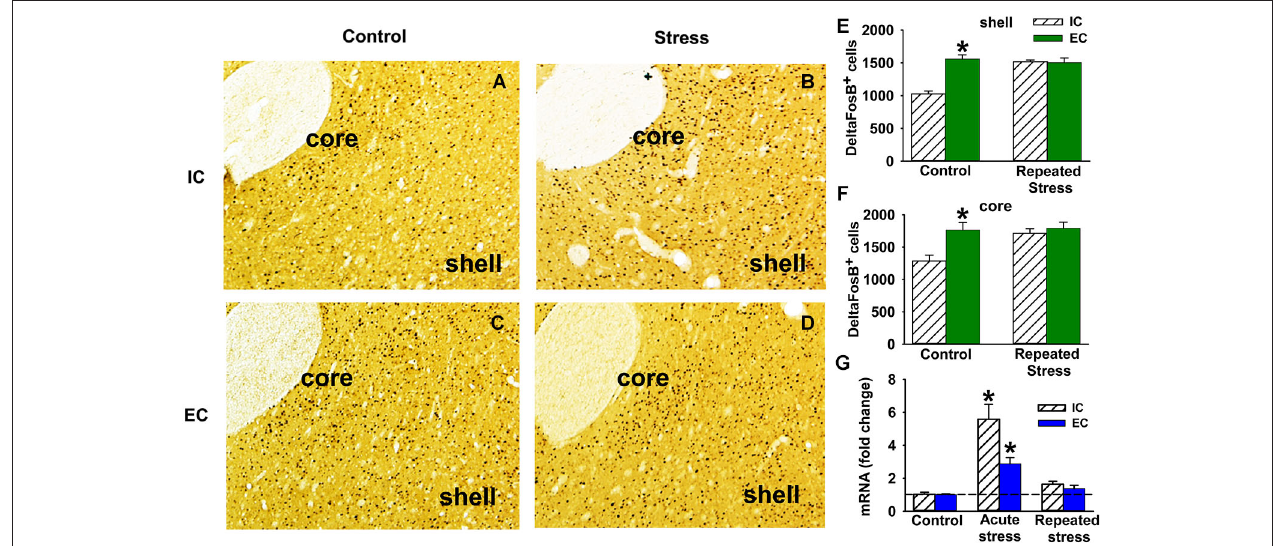
in IC and EC rats. (F) Number of ∆ FosB positive cells ( ± SEM) in NAc core induced by repeated restraint stress. (G) Fold change of ∆ FosB mRNA ( ± SEM) induced by acute and repeated restraint stress in IC and EC rats (30 min; N = 5). Asterisks (*) denote significant difference from corresponding